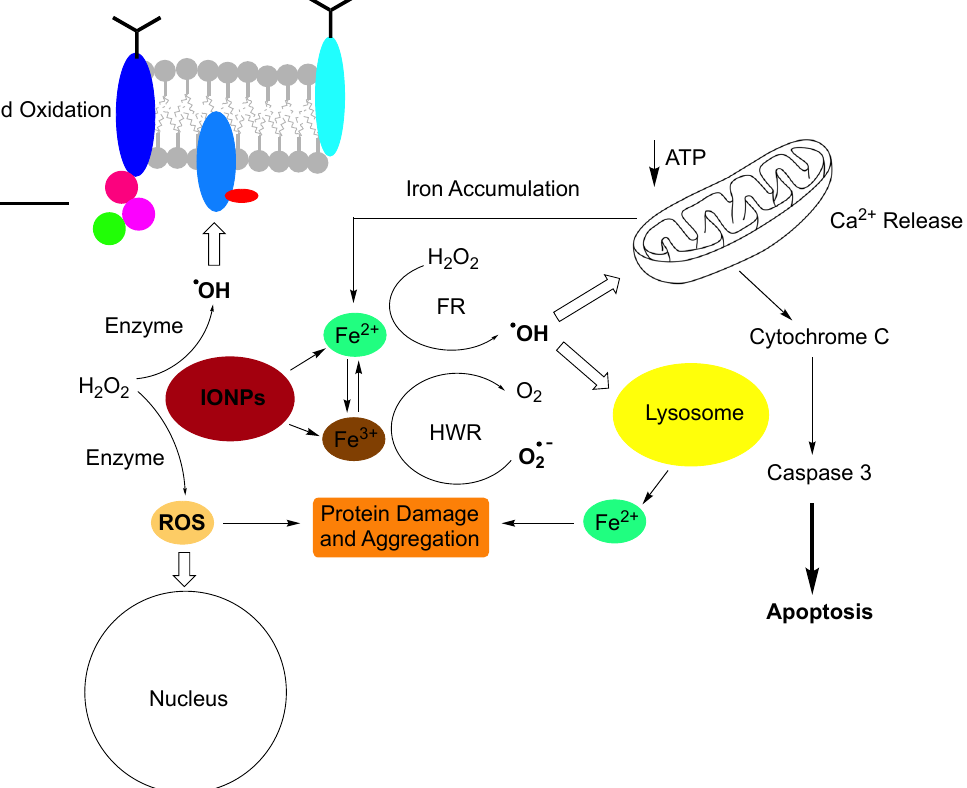
Figure 8. Pathways to iron-induced apoptosis (Ref. [127]) or ferroptosis (Refs. [149,150]). Small Iron- containing nanoparticles (IONPs) create oxidative stress by releasing Fe(II) and Fe(III) cations and by presenting a large assessable surface for redox cycling. In the presence of cellular hydrogen peroxide (H 2 O 2 ), Fe(II) enables the Fenton reaction, which created either the hydroxyl radical (HO . , shown), or higher valent iron-species Ref. [151] (not shown). Fe(III) is reduced by the superoxide anion (O 2 − ) in the Haber-Weiss reaction (Refs. [138,151]). Oxidative stress leads to membrane damage, protein damage and aggregation, nuclear damage, mitochondrial damage leading to cytochrome C release and apoptosis (Ref. [150]). Ferroptosis is triggered by radical-induced membrane damage. It is noteworthy that mitochondria do not play a part in ferroptosis (Ref. [137]).